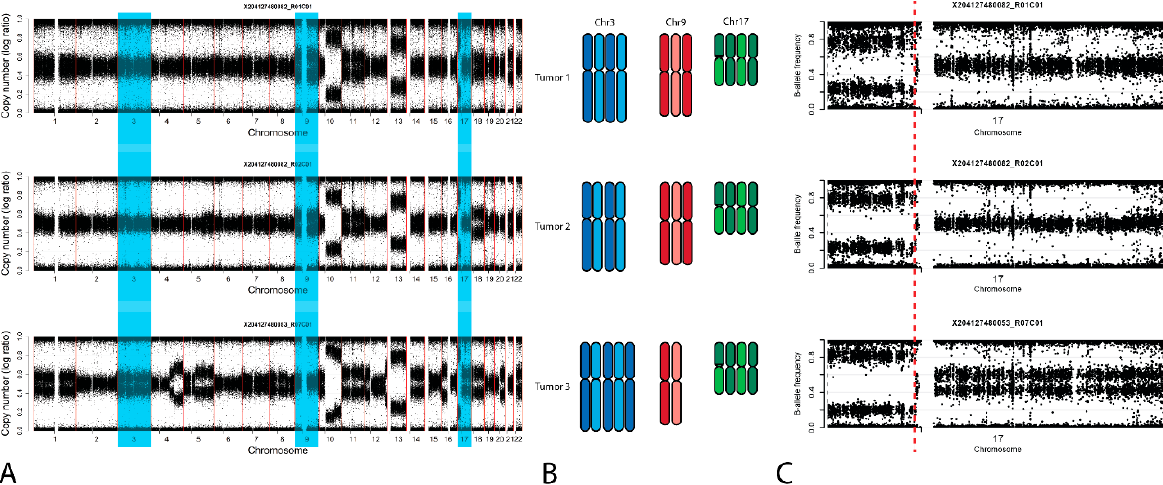
Figure 4. Representative examples of the molecular analyses performed using SNP profiling. Tumor 1 = primary GCT; Tumor 2 = leiomyosarcoma; Tumor 3 = NEC; ( A ) Total SNP profile showing relative loss of chromosome 9, 11, 13 and 18, as well as 17p, and a relative gain of 21, ( B ) copy-number (log ratio) representation of the different histological elements; ( B ) schematic representation of the explanatory constitution of chromosomes 3, 9, and 17, assuming an early polyploidization step; ( C ) B-allele frequency plot of chromosome 17, demonstrating the identical 17p11.2 breakpoint in all histologies.